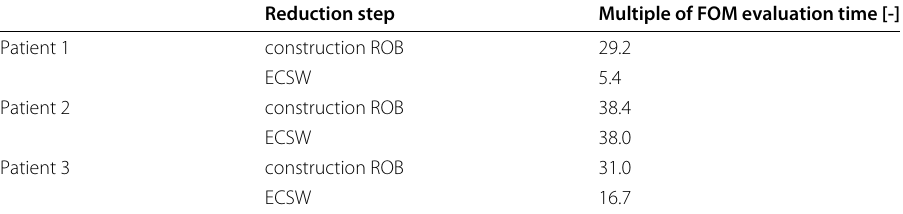
Table 7 Timing for offline stage steps of patient-specific models performed on 4 cores (Intel Xeon W-2133 (3.60GHz)). Timing is given as multiple of a single FOM evaluation time, which in turn is estimated from the mean of seven simulations per